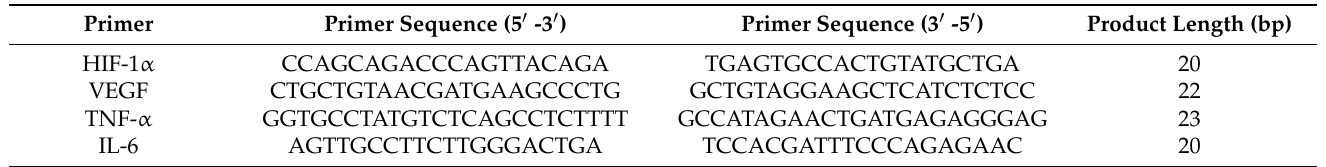
Table 1. Primers of reverse transcription PCR analysis for